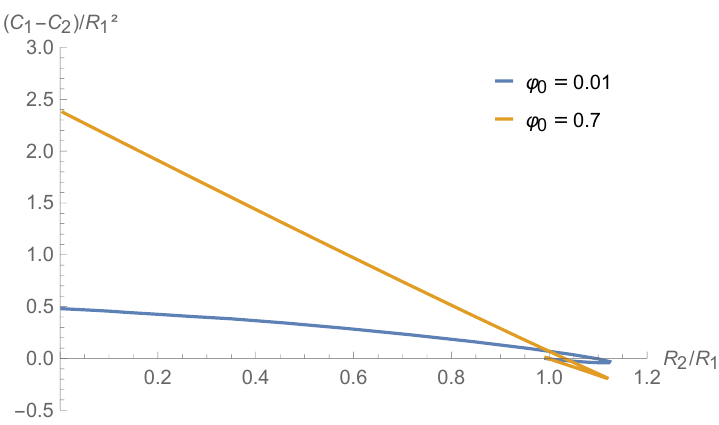
Figure 15 . The E(cid:12)mov spiral in the plane ( R 2 = R 1 ; ( C 1 (cid:0) C 2 ) = R 2 1 shrinks and for ’ 0 = 0 : 01 and ’ 0 = 0 : 7. Although it is di(cid:14)cult to see a \spiral" in the plot above, it can be inferred as it is similar to the one plotted on the top of (cid:12)gure 16. For values of ’ 0 intermediate between 0 : 01 and 0 : 8, there is a continuous family of spirals that (cid:12)lls the space between the two spirals that are